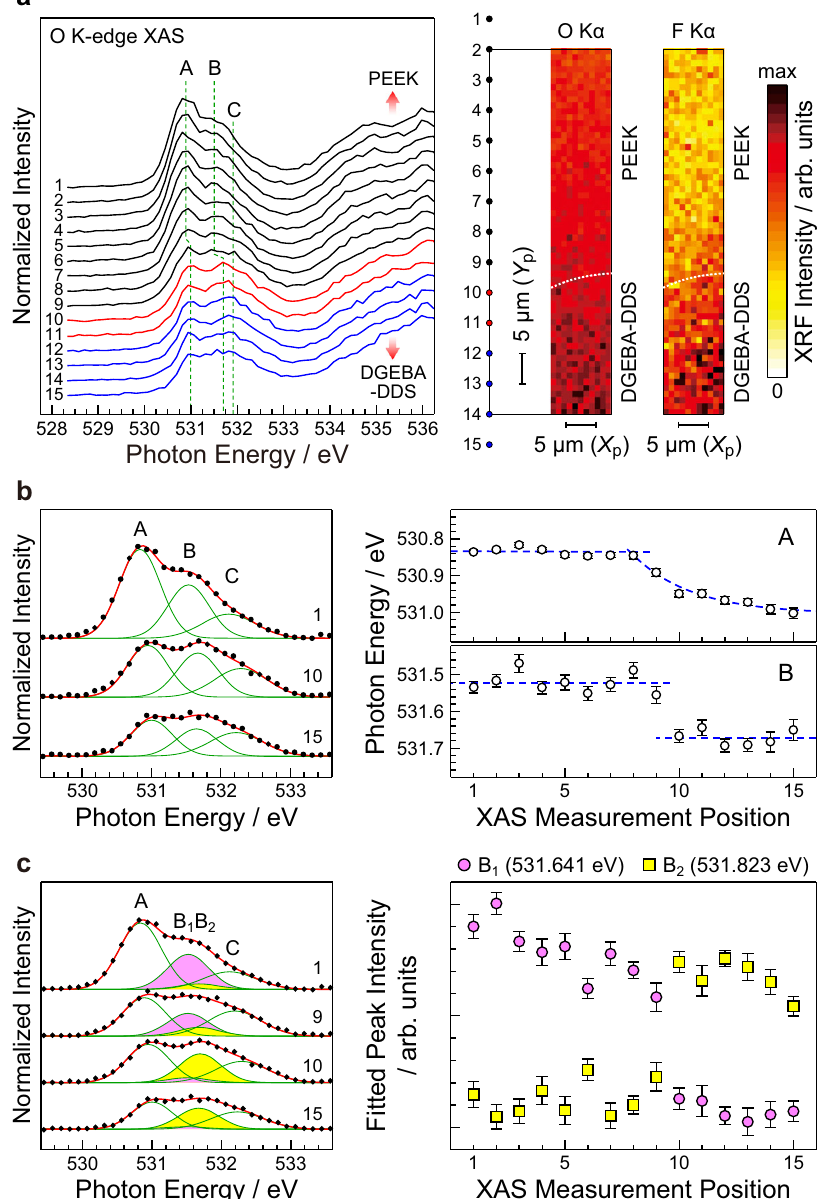
Fig. 4 Microprobe XAS measurements of the DGEBA-DDS/PEEK cross-section. a O K-edge XAS spectra by the partial- fl uorescence-yield method. The XAS measurement positions 1 – 15 are indicated together with the corresponding O K α and F K α images measured at hv = 780 eV. The interface region is indicated by the white dot curve in the XRF images. b Line shape analysis using three Gaussian components for the pre-edge peak in XAS of 1, 10, and 15 after background subtraction. Energy distribution of features A and B in XAS is also shown. c Line shape analysis using four Gaussian components for the pre-edge peak in XAS of 1, 9, 10, and 15. The intensity distribution of features B 1 and B 2 in XAS is also shown. Fitting data for all XAS spectra are given in Supplementary Fig. 3. Error bars in panels b and c are de fi ned as the standard deviation in the least-squares fi tting using the Gaussian